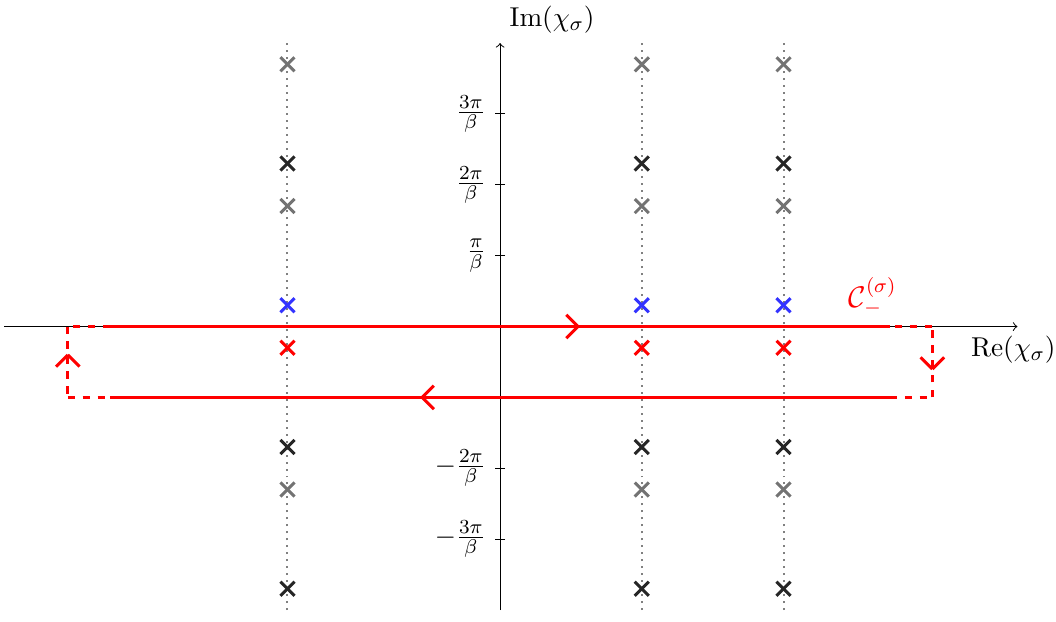
Figure 2 . For each integration variable (cid:31) (cid:27) , the contour C ( (cid:27) ) domain that are in the lower half plane. Once again, the poles that are shown in this picture are those for the SU(3) gauge theory at k = 1.